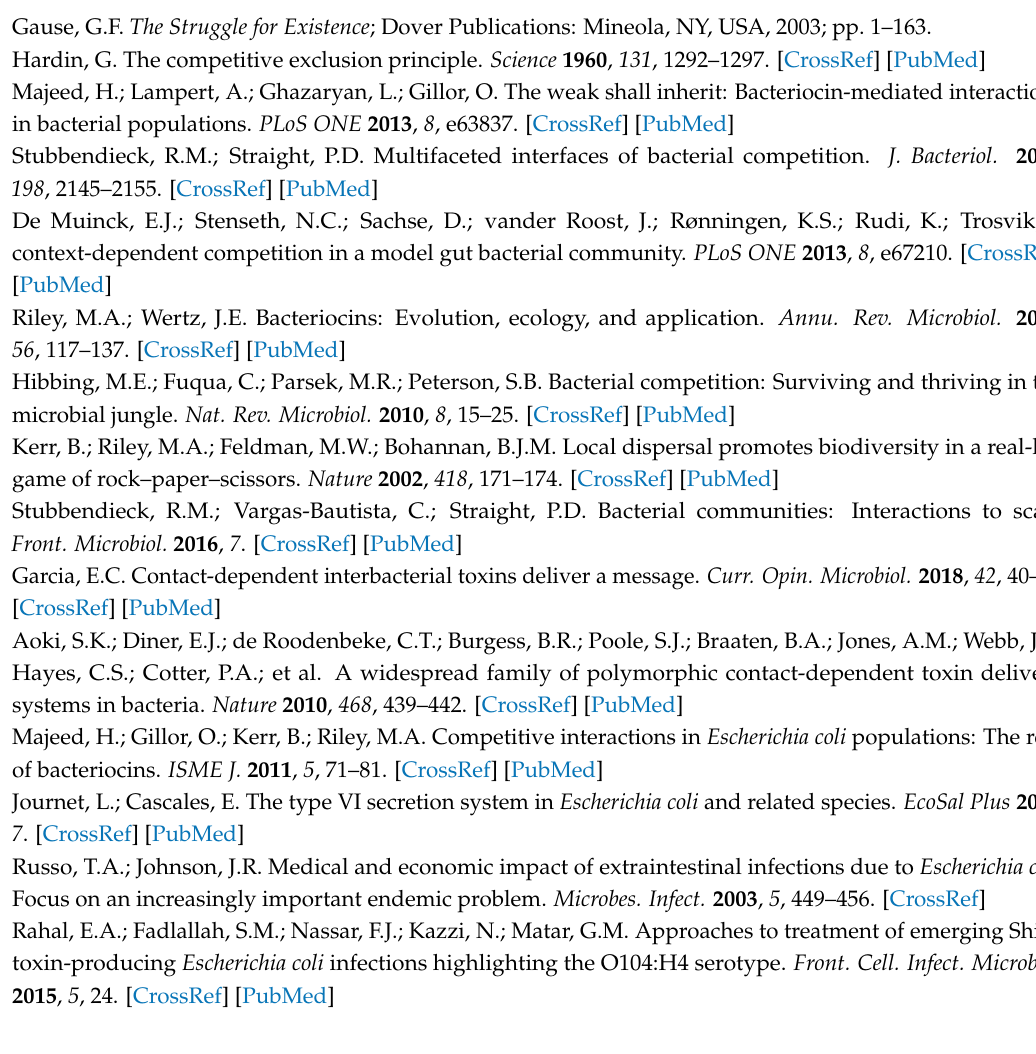
Figure S1. Omelette method results for O103 and O157 at 24 h and 7 days against each other examining zones of clearing, Figure S2. Omelette method results for O26, O103 and O178 against each other examining zones of clearing at day